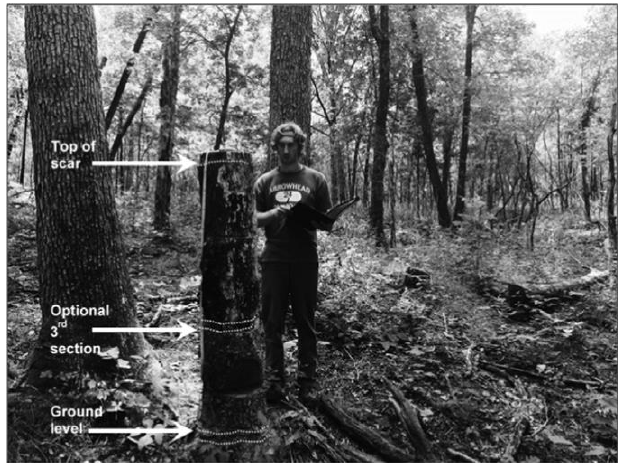
Figure 1. Field conditions at Rudolf Bennitt Conservation Area near Columbia, Missouri. Arrows indicate the height at which the cross-sections were collected along the tree bole.